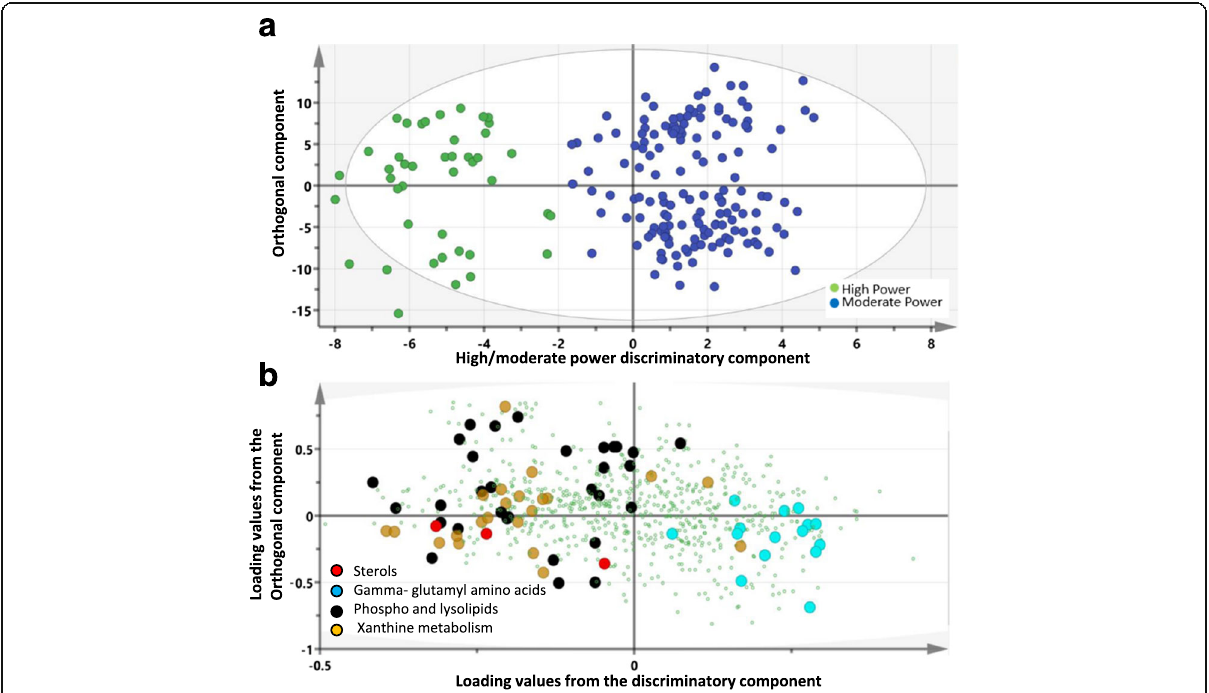
Fig. 3 OPLS-DA model of moderate- versus high-power classes of elite athletes. a A score plot showing the class-discriminatory component on the x -axis versus the first orthogonal component on the y -axis. b The corresponding loading plot showing a clustering of sterols, lipids, and xanthine metabolites at the high end of power as opposed to enrichment of gamma-glutamyl amino acids at the low end of